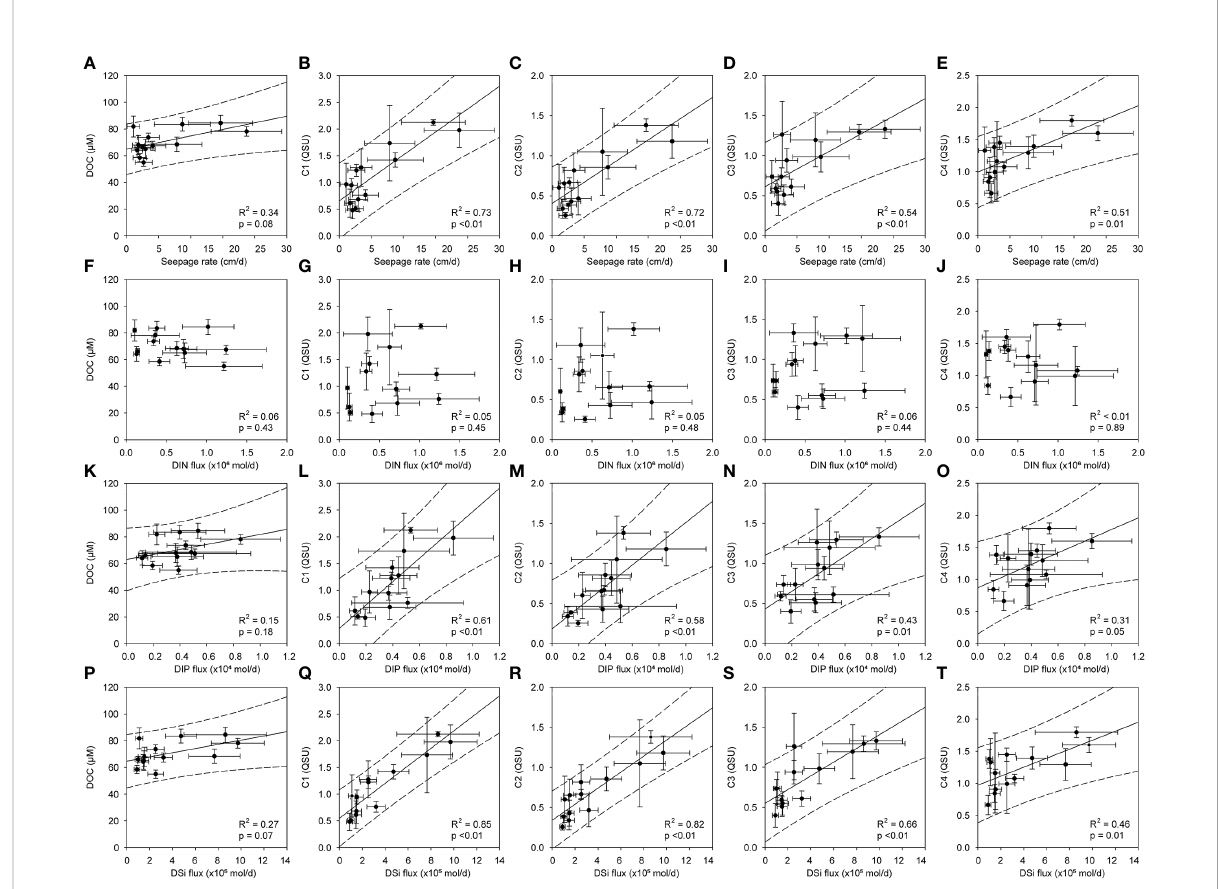
FIGURE 6 Scatterplots of the DOC concentration and the fl uorescent intensities of the FDOM components (C1 – C4) against the seepage rate (A – E) and the fl ux of inorganic nutrients (nitrate (F – J) , phosphate (K – O) , and silicate (P – T) ). The solid and dashed lines indicate the regression lines and the prediction intervals of the scatterplots,